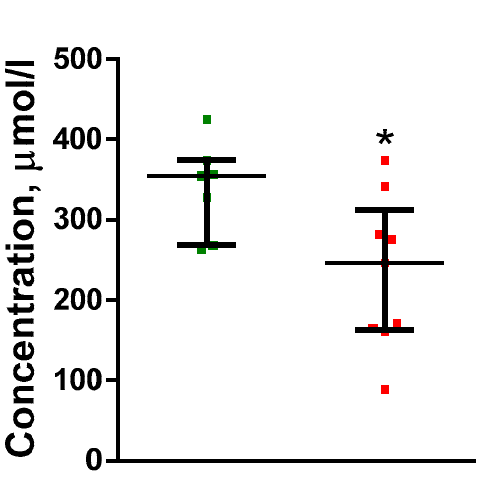
Figure 5. Plasma uric acid concentration in the patients at risk of developing Parkinson’s disease and in the controls. * p < 0.05, statistically significant differences. Data presented as a median with an interquartile range and min–max values.